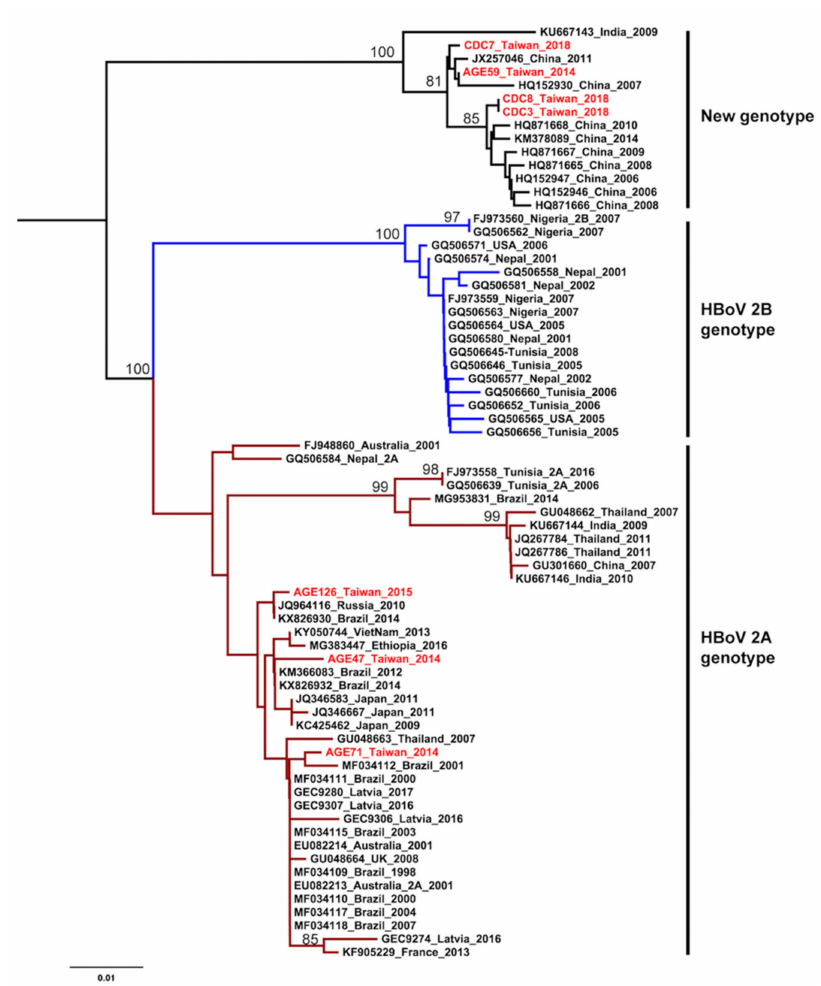
Figure 2. Phylogenetic analysis of human bocavirus 2 using the neighbor-joining method. The phylogenetic tree was reconstructed based on the HBoV2 partial VP1 gene. The stability of the tree topology was evaluated by using 1000 bootstrap replicates. Only bootstrap values greater than 75% are shown on the branch. The red texts represent HBoV2 isolates in Taiwan from the children with AGE. Brown and blue clades are represented HBoV2A and HBoV2B, respectively.